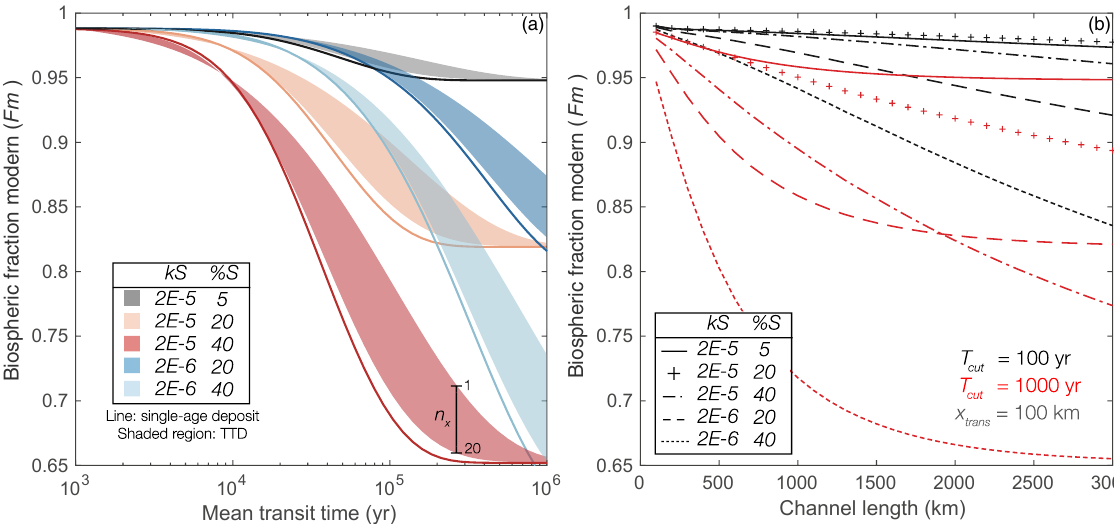
Figure 4. Model predictions of the radiocarbon content of POC. (a) Predicted relationships between sediment mean transit times (MTTs) and the Fm of biospheric POC for POC cycling models with variable proportions of slow POC (% S ) and variable slow POC consumption rate constants (kS; yr − 1 ). Note that % S is equal to the proportion of slow POC at steady state. The Fm values shown as shaded areas were calculated using sediment transit time distributions (TTDs) with shapes set by between 1 and 20 transport events (Fig. 3) and MTTs between 10 3 and 10 6 years. The model results show that plausible sediment TTDs yield significantly different relationships between the MTT and Fm relative to predictions for systems with a single transit time (solid bold lines). While TTD shape is an important factor reflected in the vertical range of each shaded area, the model results suggest that large differences of OC cycling (different colors; see figure legend) are distinguishable in the relationships between the MTT and Fm. (b) Predicted downstream profiles of Fm for a fixed x tran (100km) but variable T cut (100 and 1000 years) and POC cycling parameters (different line styles; see figure legend). The model results suggest that observed downstream profiles are sensitive to both sediment storage timescales, which are controlled by T cut , as well as OC cycling